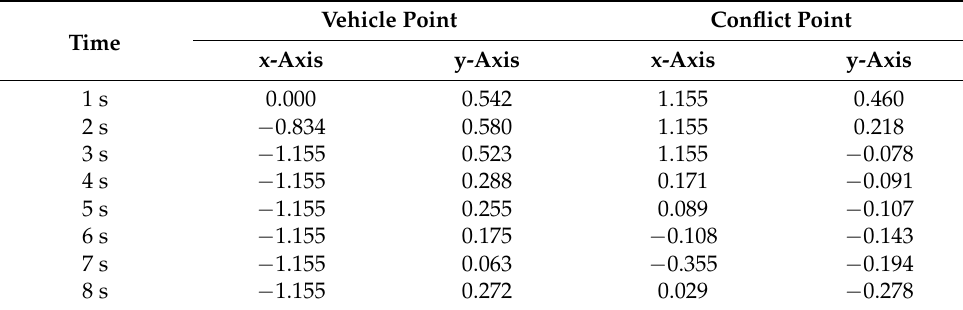
Table 1. Vehicle projection points and conflict projection points.